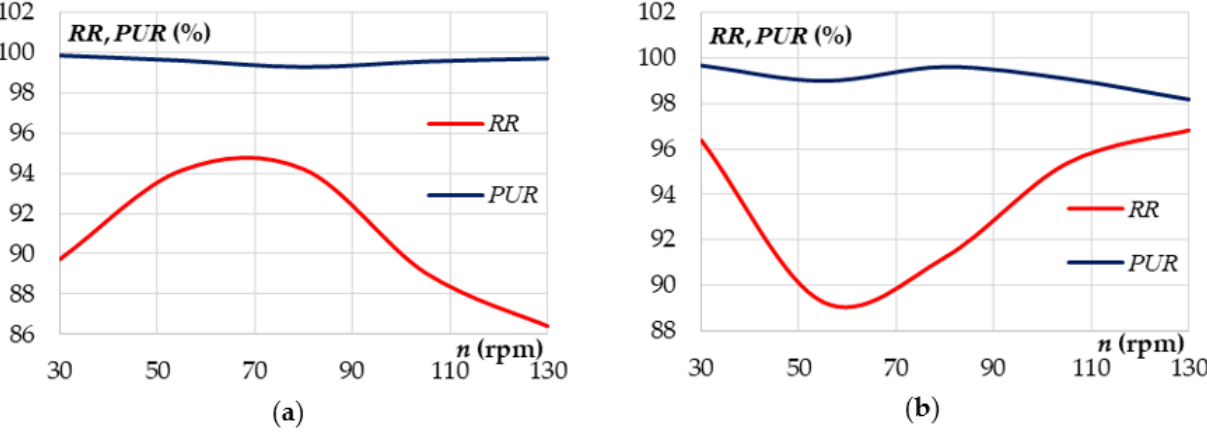
Figure 11. Dependence of recovery rate ( RR ) and purity factors ( PUR ) on rotary speed of the drum electrode for mixture of PET (50%) and PE-HD (50%) tribocharged by 5 min for deflecting electrode position I ( a ) and II ( b ).